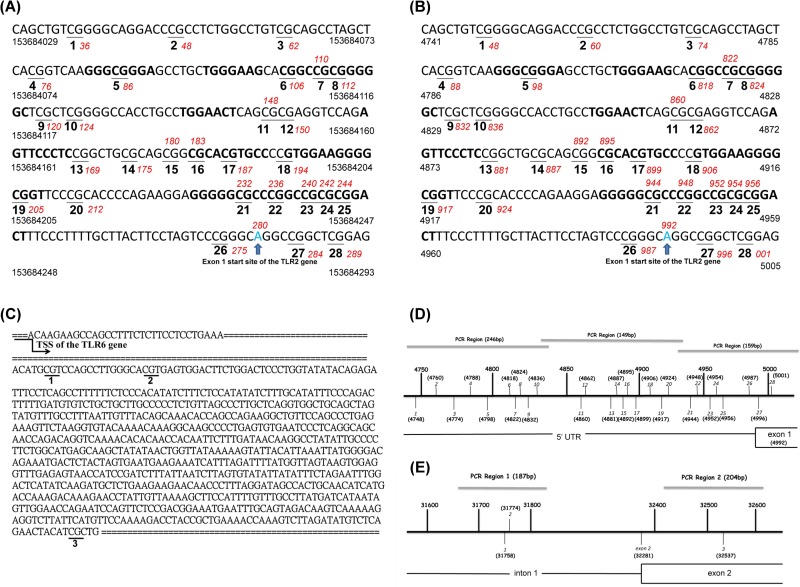
Diagrams showing CpG site locations of the TLR2 and TLR6 genes (genome build “GRCh38.p13”).(A)~(B): A zoom of the 28 CpG sites assayed in the TLR2 gene and their genomic sequences based on NCBI Reference Sequence (NC_000004.12 and NG_016229.1). (C): A zoom of the 3 CpG sites assayed in the TLR6 gene and their genomic sequences based on NCBI Reference Sequence (NG_028087.1). (C): Diagram showing CpG site locations of the TLR2 gene. The CpG site #27 and #28 were in the exon 1 of the gene body, and the others were in the promoter regions. (D): Diagram showing CpG site locations of the TLR6 gene. CpG site #1 and #2 were in the intron 1, and #3 was in the exon 2 of the gene body.